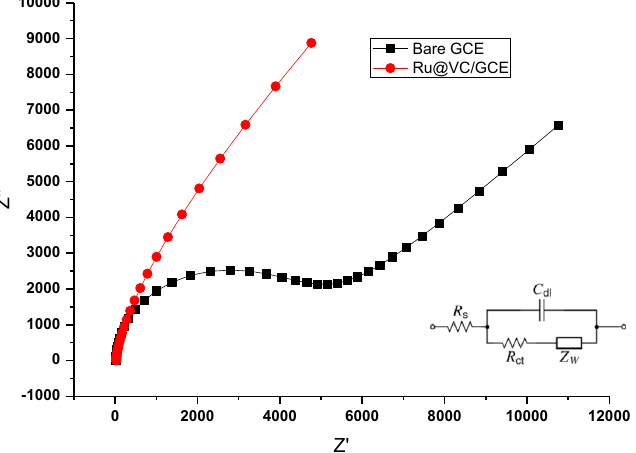
Figure 4. Nyquist plot of bare GCE and Ru@VC/GCE. Inset: The Randles equivalent circuit model (R s : solution resistance, C dl : constant phase element, R ct : the charge transfer resistance, Z w : Warburg impedance), which was used to fit the data.